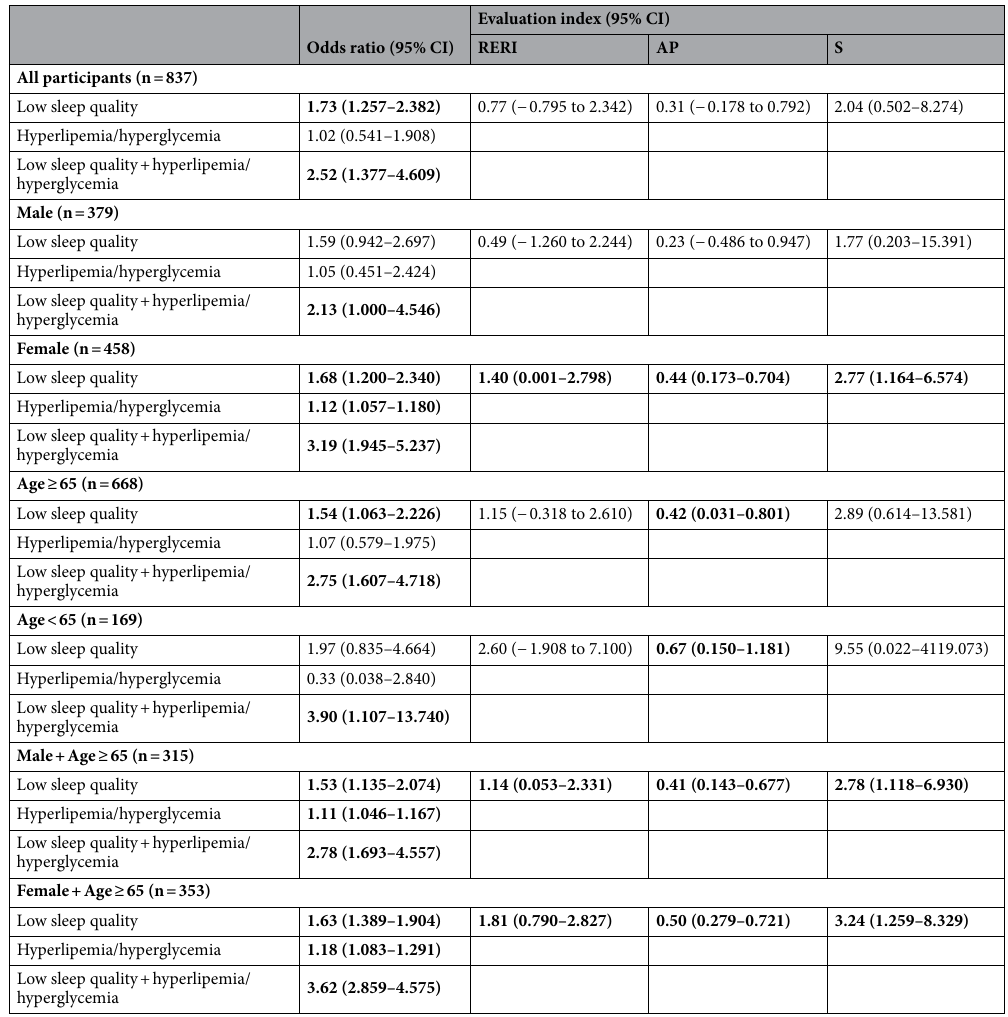
Table 4. Additive effect of PSQI with hyperlipemia/hyperglycemia on osteoarthritis. 95% CI 95% confidence interval, RERI relative excess risk due to interaction, AP attributable proportion, S synergy index. Significant differences ( P < 0.05) are highlighted in bold. Models were adjusted for age, sex, monthly income, education level, occupation, smoking, alcohol intake frequency, tea intake frequency, and duration of